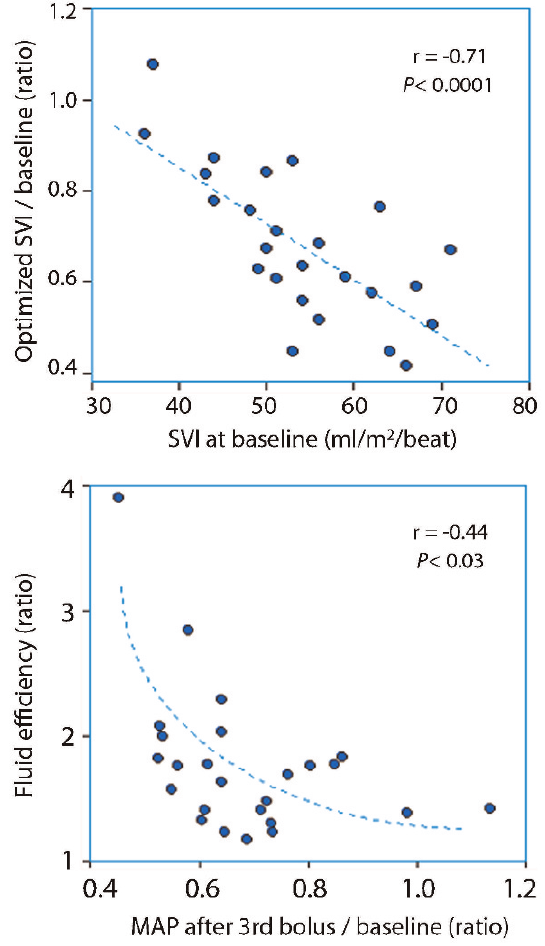
Figure 4 - The relationship between preoperative and optimized stroke volume index (SVI) in patients receiving Ringer’s lactate for fluid volume optimization (top). The fluid efficiency of Ringer’s lactate in these patients was greater when there was a profound decrease in mean arterial pressure (MAP, bottom).